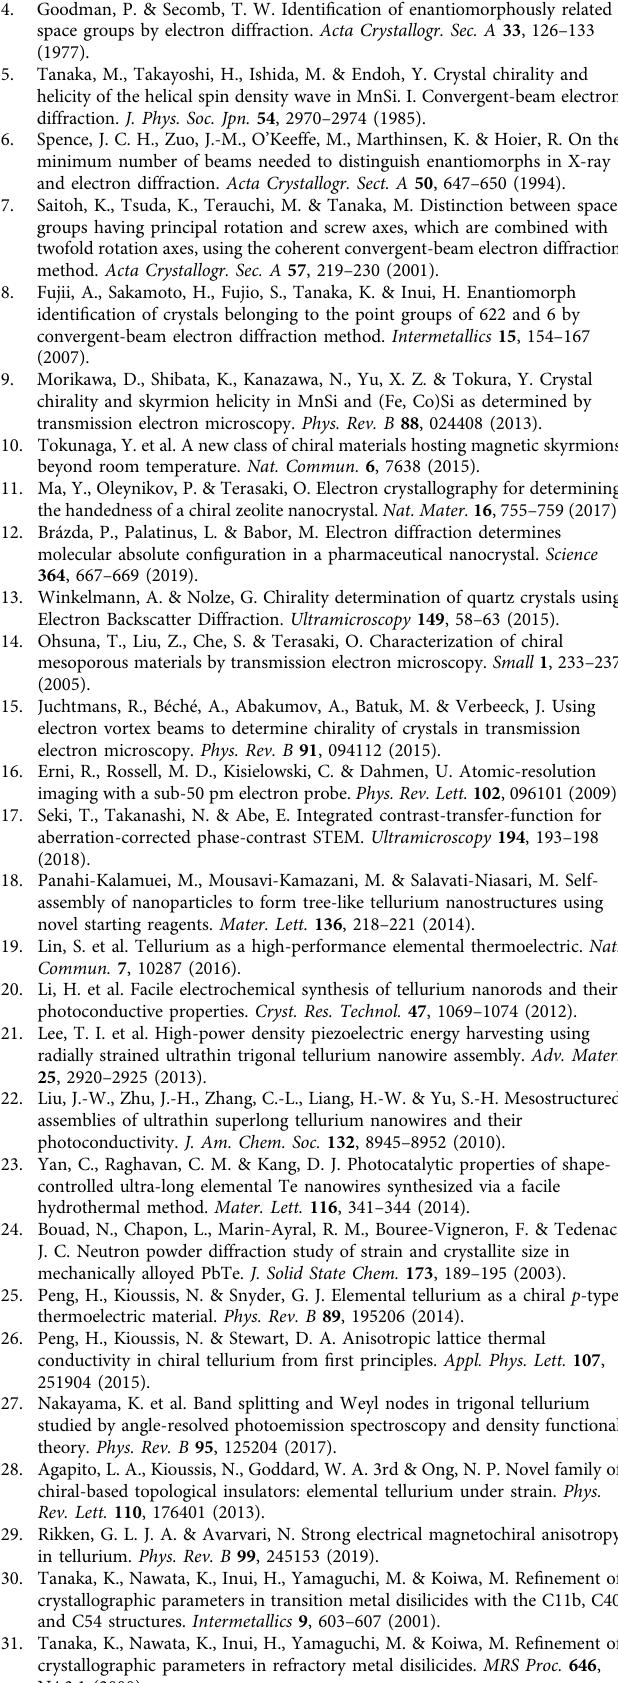
STEM simulation . STEM image simulations were performed using a free software package QSTEM (http://www.qstem.org), which is based on the multi-slice algo- rithm. Simulation parameters were roughly the same for all the crystals. The simulation used the STEM mode and included thermal diffuse scattering by the frozen phonon approximation. A 80× 80 pixel area and a probe array of 400 × 400 pixel area were employed. Box mode with a size of 60Å× 60Å× 100 Å ( x × y × z ) was used and the zone axes were reached by sample tilt function. In total, there were 100 slices along the zone axes, each slice was of one angstrom thick (50 slices with two angstrom thick per slice for TaSi 2 ). The defocus, astigmatism, and spherical aberration C3 were all set to zero in order to get the closest representation of the real structure models. The inner and outer angles for detector 1 and detector 2 were 42°, 180°, and 7.8°, 16°, respectively, which were consist with the experi- mental